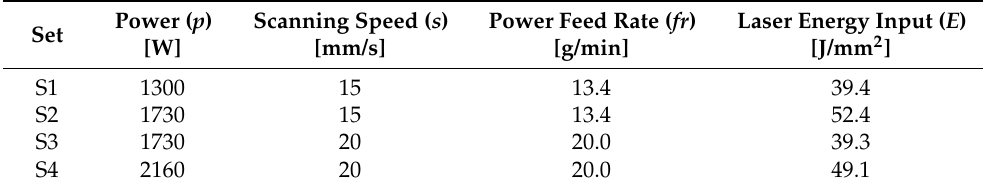
Table 3. Combinations of process parameters settled to perform DED depositions [S1: set1, S2: set2, S3: set3, S4: